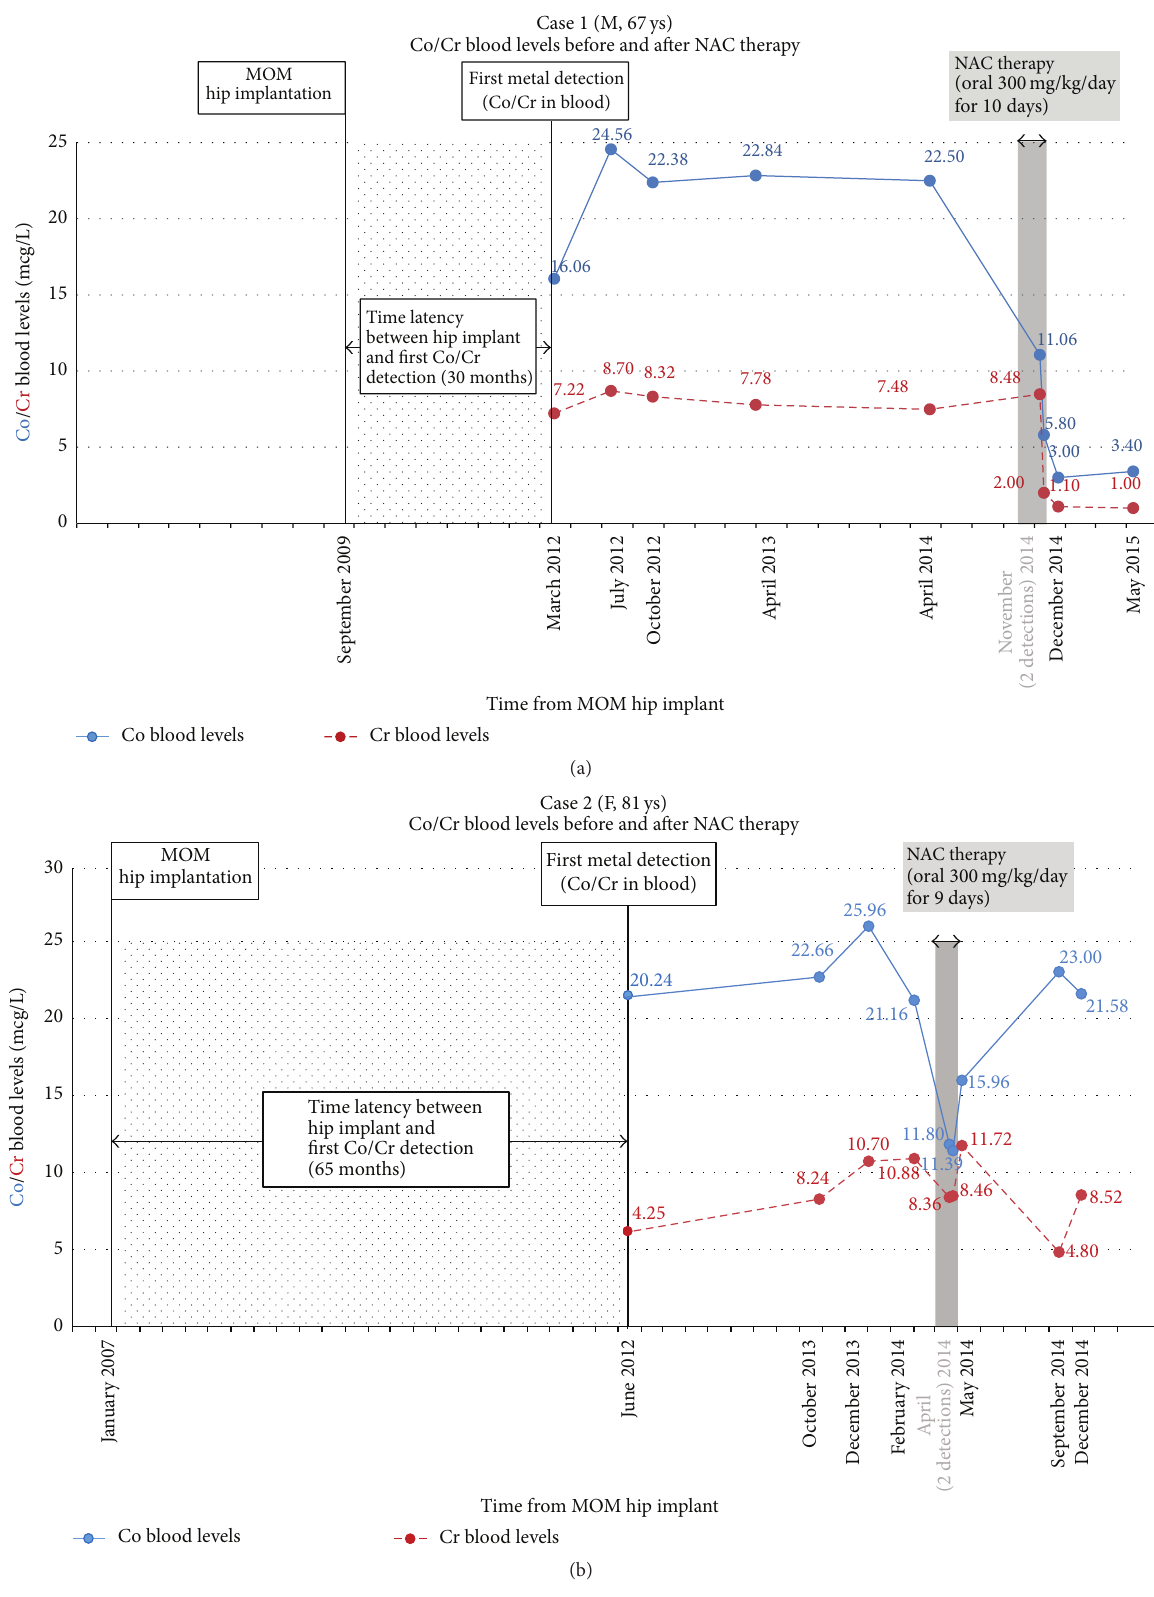
Figure 1: (a) Cobalt (Co) and chromium (Cr) blood levels in case 1. In the figure are reported time latency from MOM implant and first metal detection and metal blood concentrations before, during, and after chelation treatment with high-dose oral NAC. (b) Cobalt (Co) and chromium (Cr) blood levels in case 2. In the figure are reported time latency from MOM implant and first metal detection and metal blood concentrations before, during, and after chelation treatment with high-dose oral